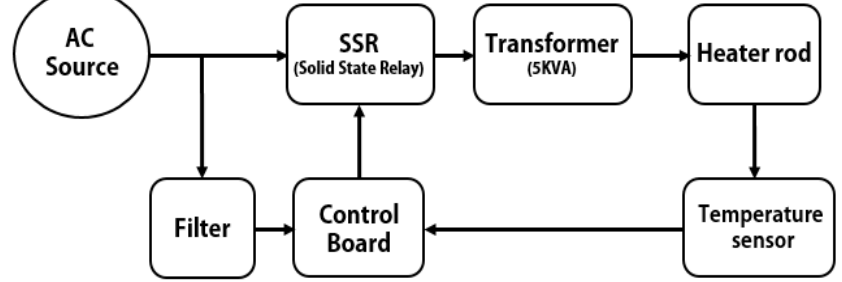
Figure 2. Block diagram of the heating system. The arrow lines indicate the direction of operation of devices.